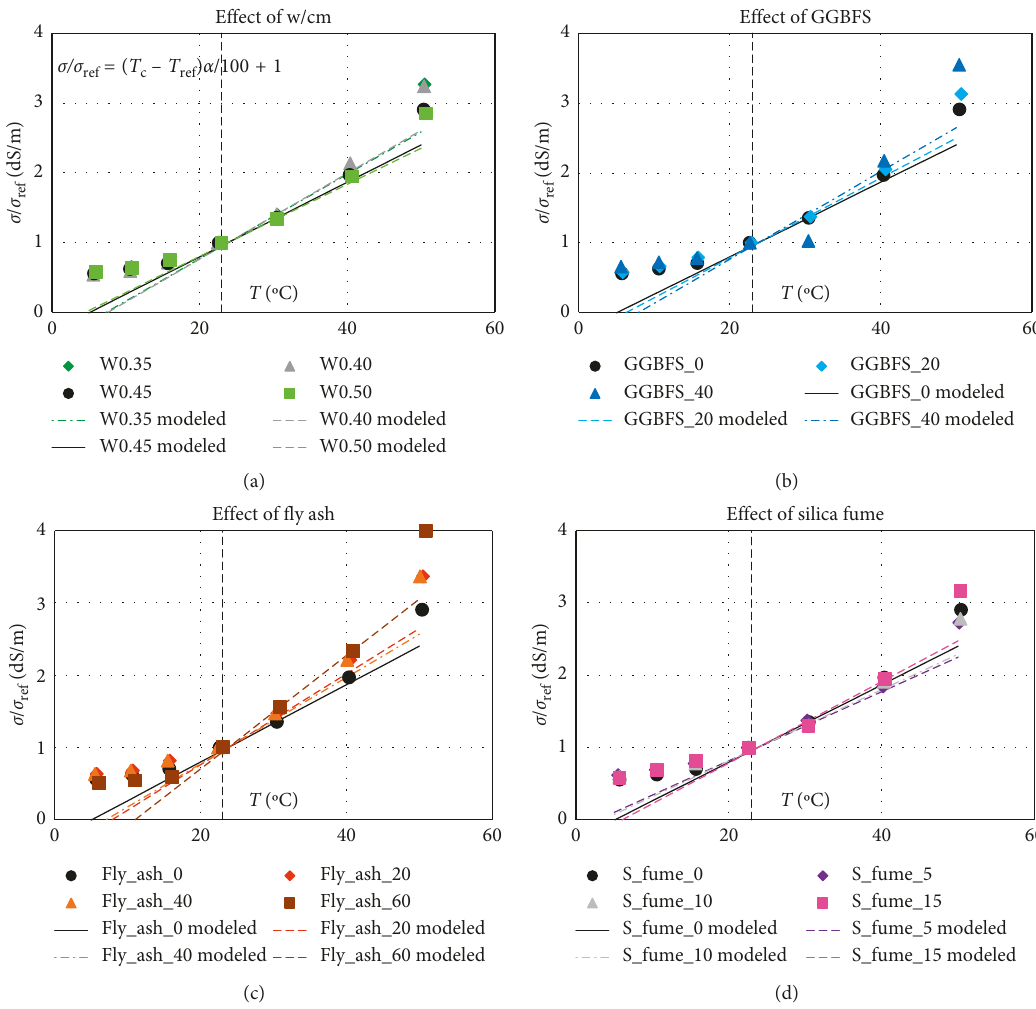
Figure 3: Experimental and modeled σ/σ ref at various T c based on LTC (equation 1) for all mixtures. Vertical dashed line marks T ref (cid:31) 23 Table 3: Calibrated values of coefficient α in LTC (equation 1) for all tested mixtures and values of R 2 . Mix.